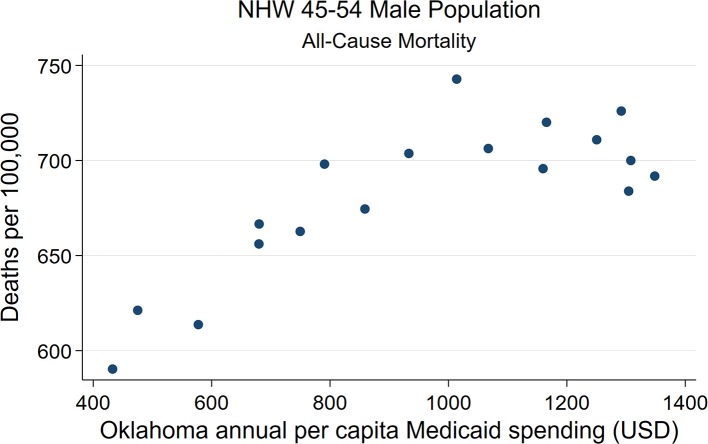
State-level Oklahoma Medicaid spending linear regression plot (crude association) with male NHW45-54 all-cause mortality.